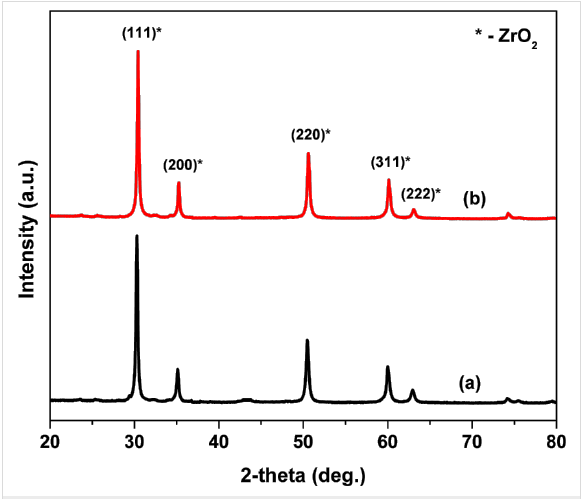
Figure 1: XRD patterns of (a) ZrO 2 , and (b) Pt(1%)-ZrO 2 .